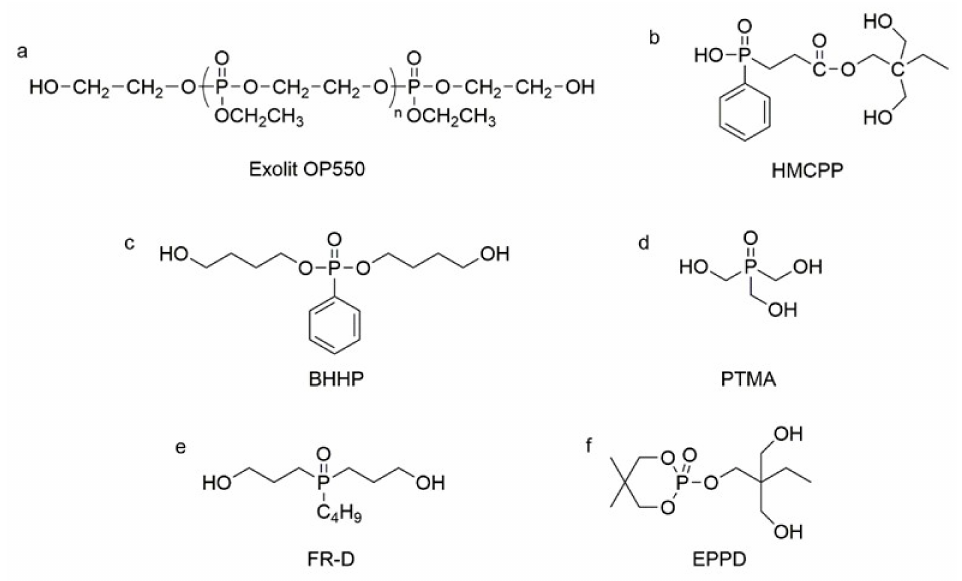
Figure 4. Chemical structures of phosphorus reactive flame retardants: ( a ) Clariant’s Exolit OP550 diol; ( b , c ) phosphonate diols; ( d ) trihydroxy phosphine oxide; ( e ) phosphine oxide-containing diols; ( f ) flame-retardant diol with phosphorus-containing side